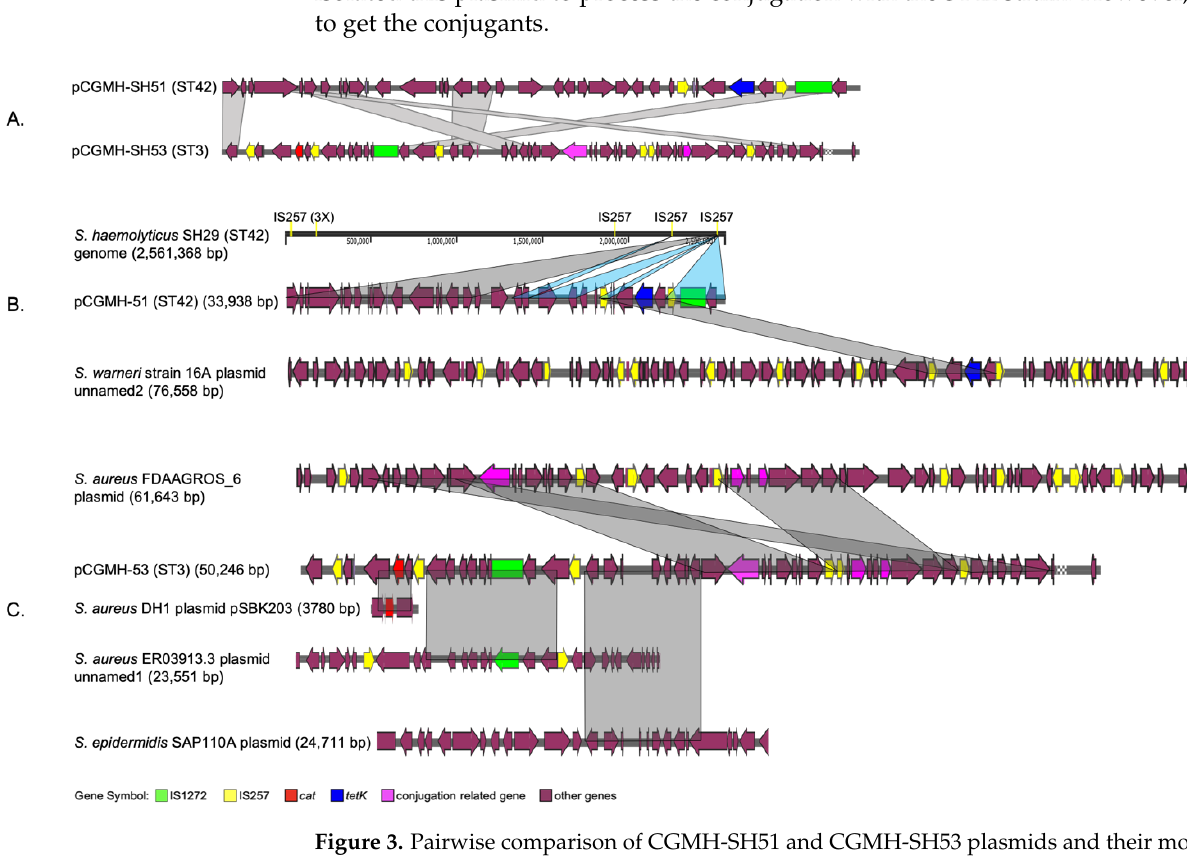
Figure 3. Pairwise comparison of CGMH-SH51 and CGMH-SH53 plasmids and their most identical sequences. Plasmids of CGMH-SH51 (pCGMH-SH51) and CGMH-SH53 (pCGMH-SH53) were compared with each other ( A ) and their most identical sequences, as identified from NCBI blast, are shown in ( B , C ). Grayscale indicates sequence similarities > 90%. Light blue indicates sequences close to the CGMH-SH51 genome (similarity > 90%). Gene Symbols and different genes are represented by various colors.